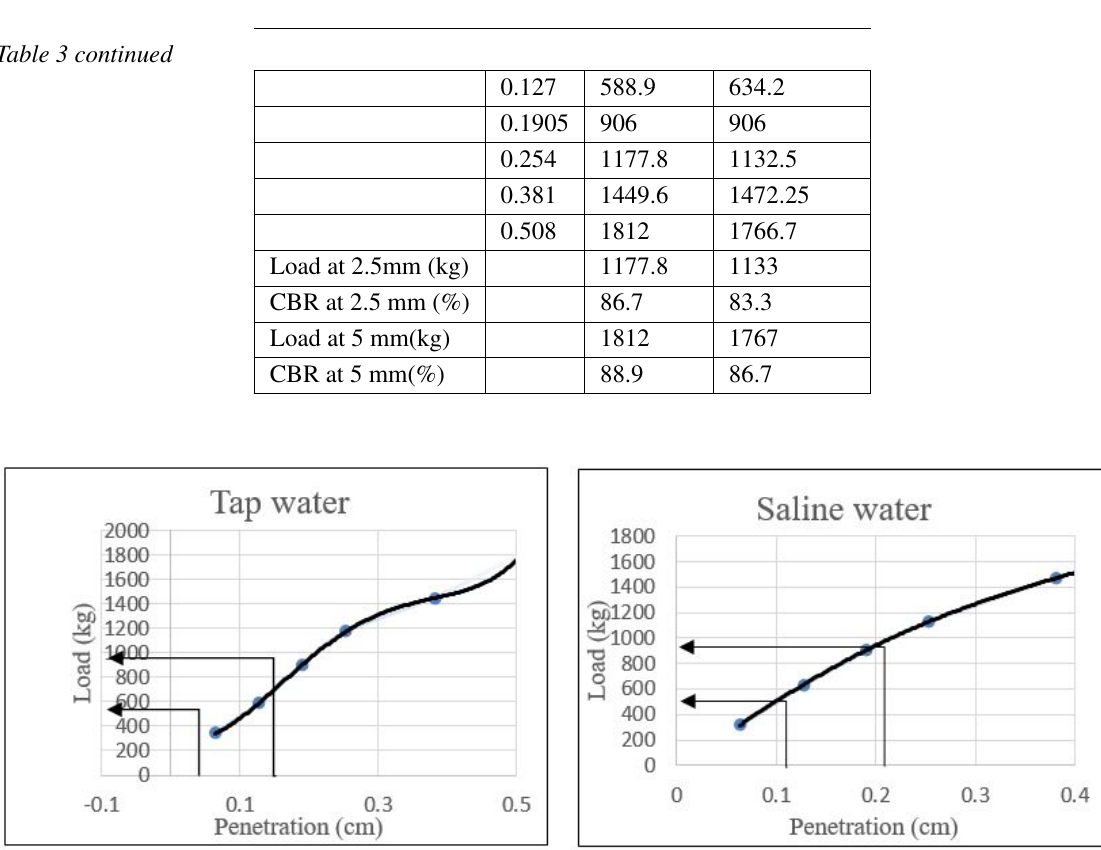
Figure 3. Obtained stress from relationbetween load and